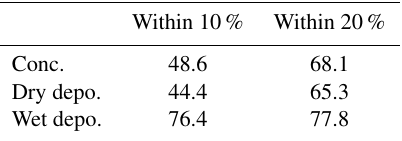
Table 2. Relative frequency in percent of concentration and deposi- tion values with relative errors smaller than 10 and